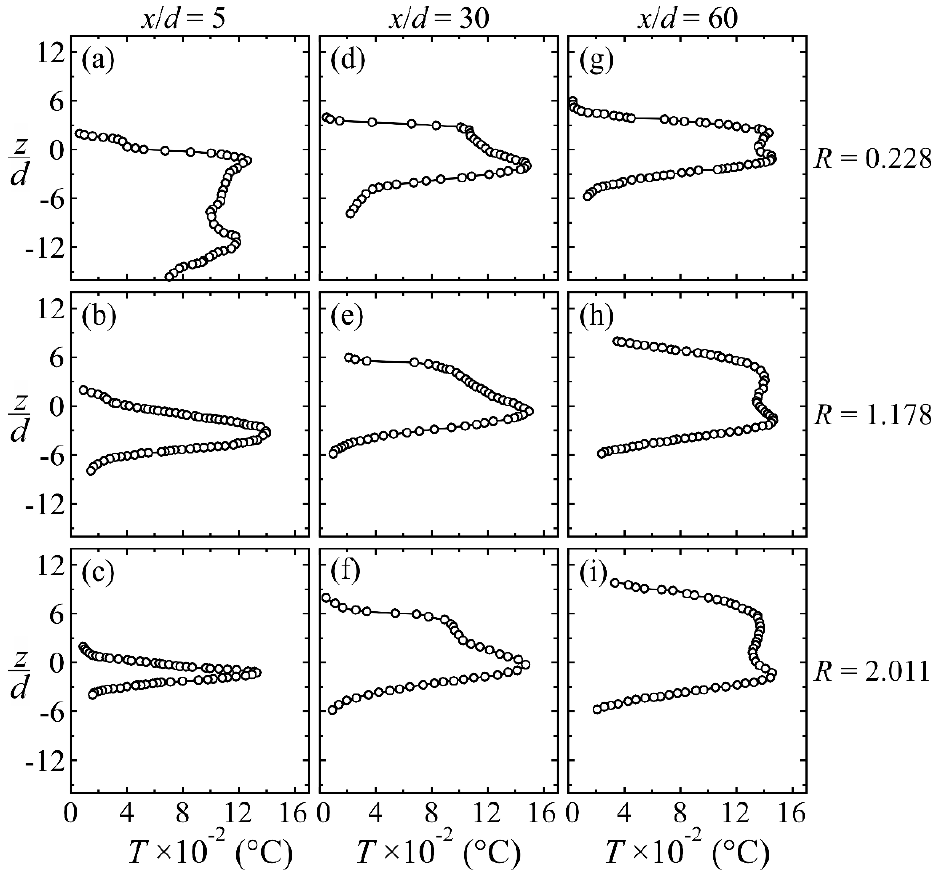
Figure 11. Time-averaged temperature distributions at R = 0.228, 1.178, and 2.011. θ = 15°.